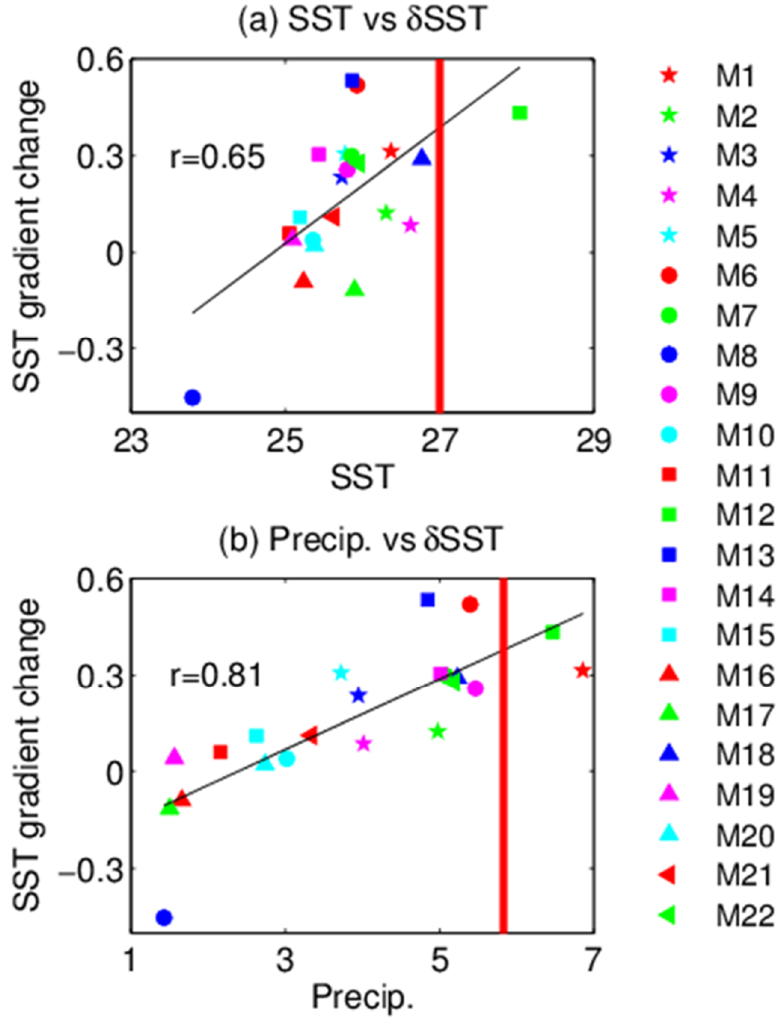
Figure 7. Relationships of the projected future east–west SST (°C) gradient changes between equatorial eastern (140° W–90° W, 2° S–2° N) and western (140° E–170° W, 2° S–2° N) Pacific with the present-day ( a ) equatorial Pacific cold tongue (160 °E–90 °W, 2 °S–2 °N) SST and ( b ) equatorial western Pacific precipitation (mm/day) among the 22 CMIP5 models. The red lines in ( a ) and ( b ) indicate the corresponding observed values. The inter-model correlation (r) in each panel is given in the top-left